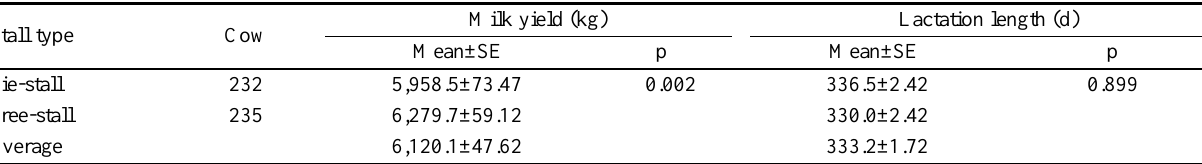
Table 1. Means (±SE) of milk yield and lactation length in two different stall types Stall